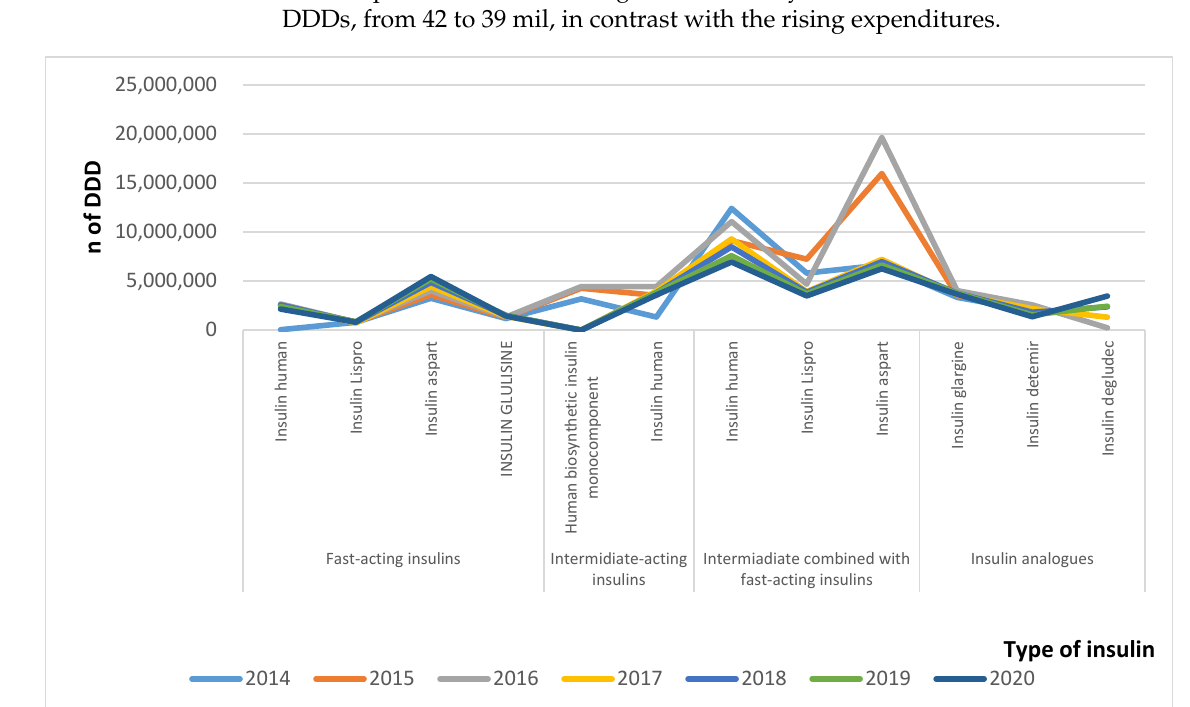
Figure 1. Utilization of insulins in DDD.